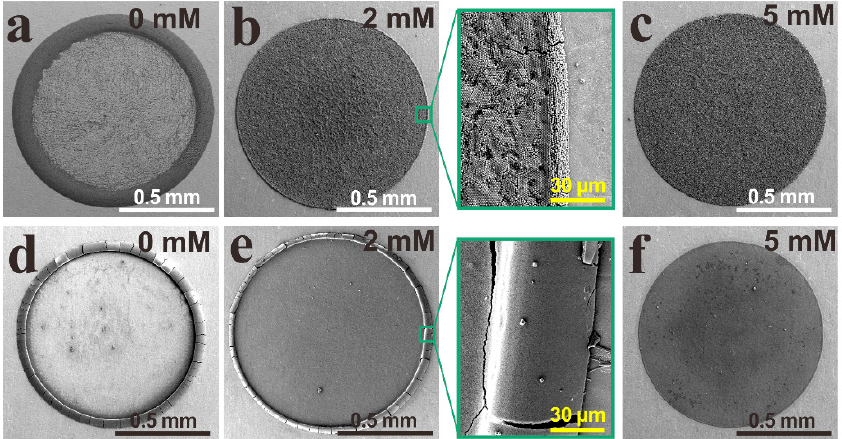
Figure 5. SEM images of the deposit patterns dried from suspension droplets containing mono- dispersed F-PS particles with different sizes and trace amounts of MgCl 2 on graphene. The diameter of mono-dispersed particles: ( a – c ) 1.0 μ m; ( d – f ) 0.1 μ m. The zoomed-in SEM images show the selected areas at the rim of the corresponding deposit patterns.